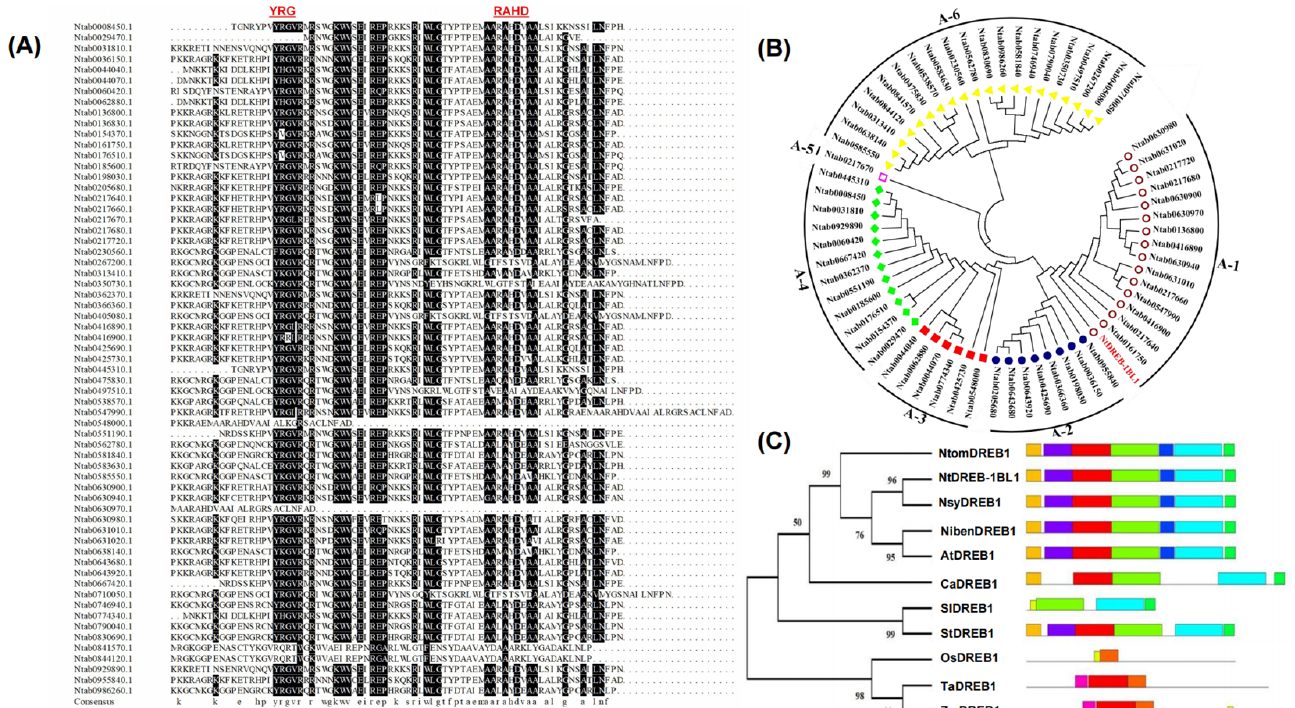
Figure 1. Sequence alignment and phylogenetic analysis of NtDREB family in N. tabacum . ( A ) AP2 domain analysis of NtDREB family. ( B ) Phylogenetic analysis of NtDREB family. ( C ) The distribu- tion of conserved motifs in DREB. The protein sequences were from Nicotiana tomentosiformis (NtomDREB1); Nicotiana sylvestris (NsyDREB1); Nicotiana tabacum (NtDREB-1BL1); Nicotiana benthami- ana (NibenDREB1); Solanum lycopersicum (SlDREB1, XP_019068359.1); Capsicum annuum (CaDREB1, PHT68900.1); Arabidopsis thaliana (AtDREB1, AT4G25490); Oryza sativa (OsDREB1, NP_001359120.1); Zea mays (ZmDREB1, NP_001105876.2); Triticum aestivum (TaDREB1, AAX13289.1); Solanum tuberosum (StDREB1, NP_001274894.1). Different color blocks represented